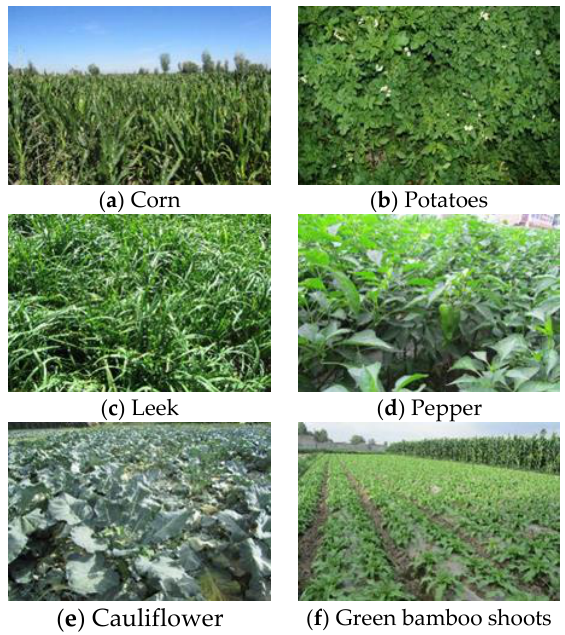
Figure 4. Ground object types in the data collection period.